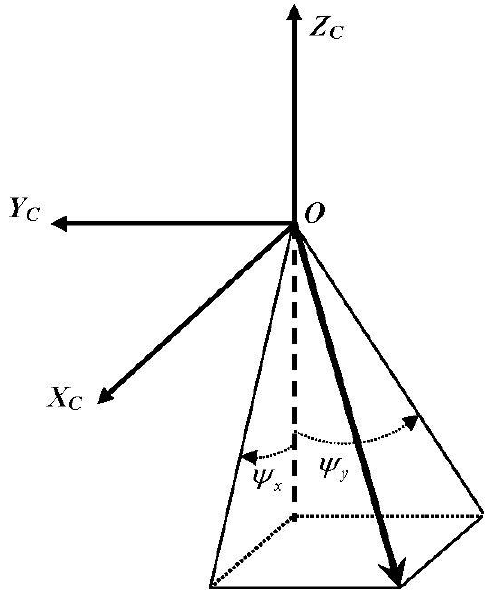
Figure 3. Directional angle of charge coupled device (CCD)